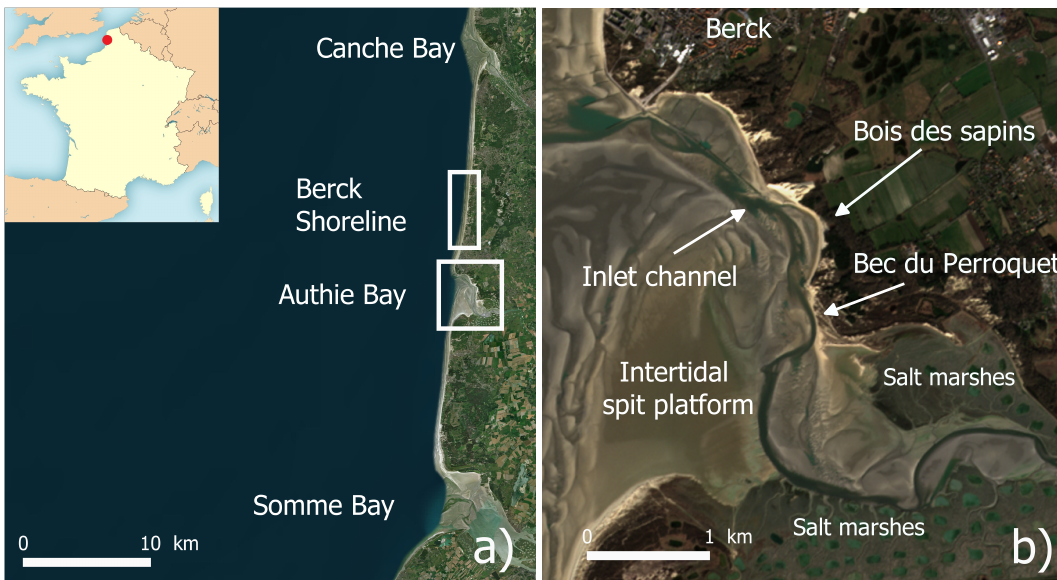
Figure 1. Location of the study sites on the northern coast of France. ( a ) The white rectangle box represents a portion of the north coast along Berck city between the bays of Authie and Canche, while the white square box indicates the Authie estuary. ( b ) Zoom of the Authie Bay. Bois des Sapins and Bec du Perroquet labels refer to specific areas that have experienced erosion in recent years. Source: Sentinel-2 RGB composite